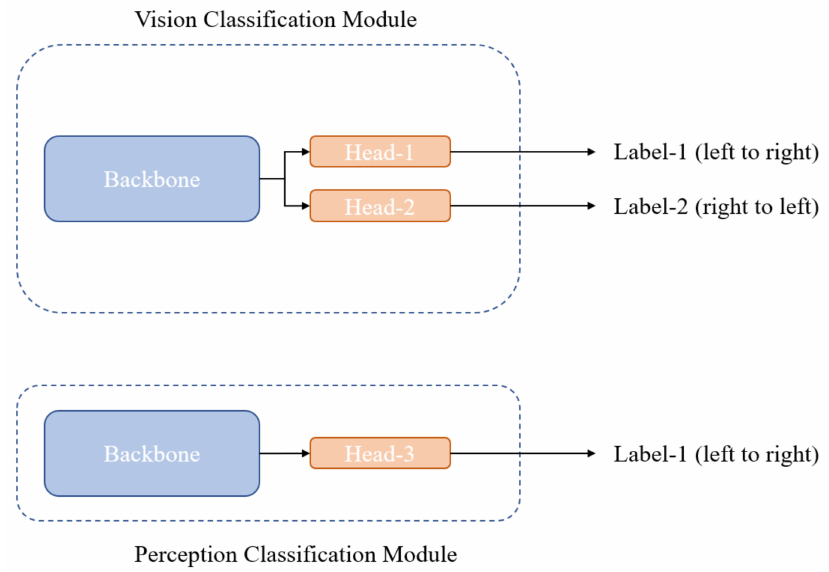
Figure 3. The architecture of the proposed model LLNet (training phase).